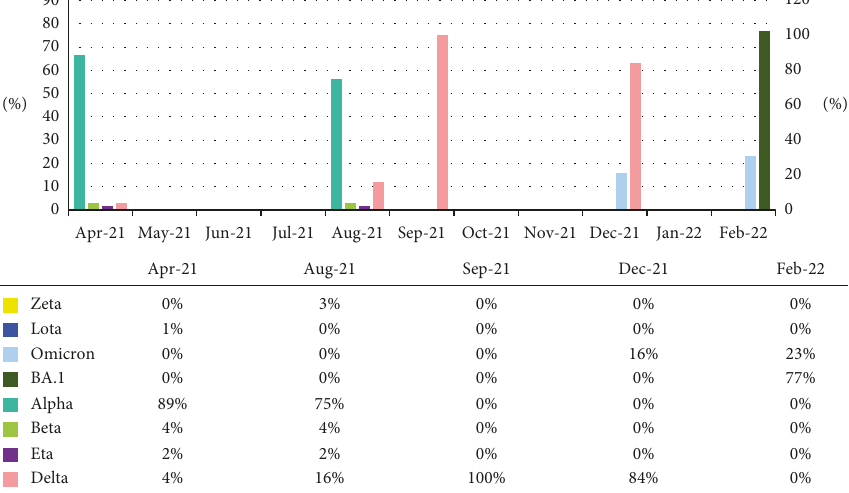
Figure 2: Distribution of SARS-CoV-2 lineages in months in Turkey.